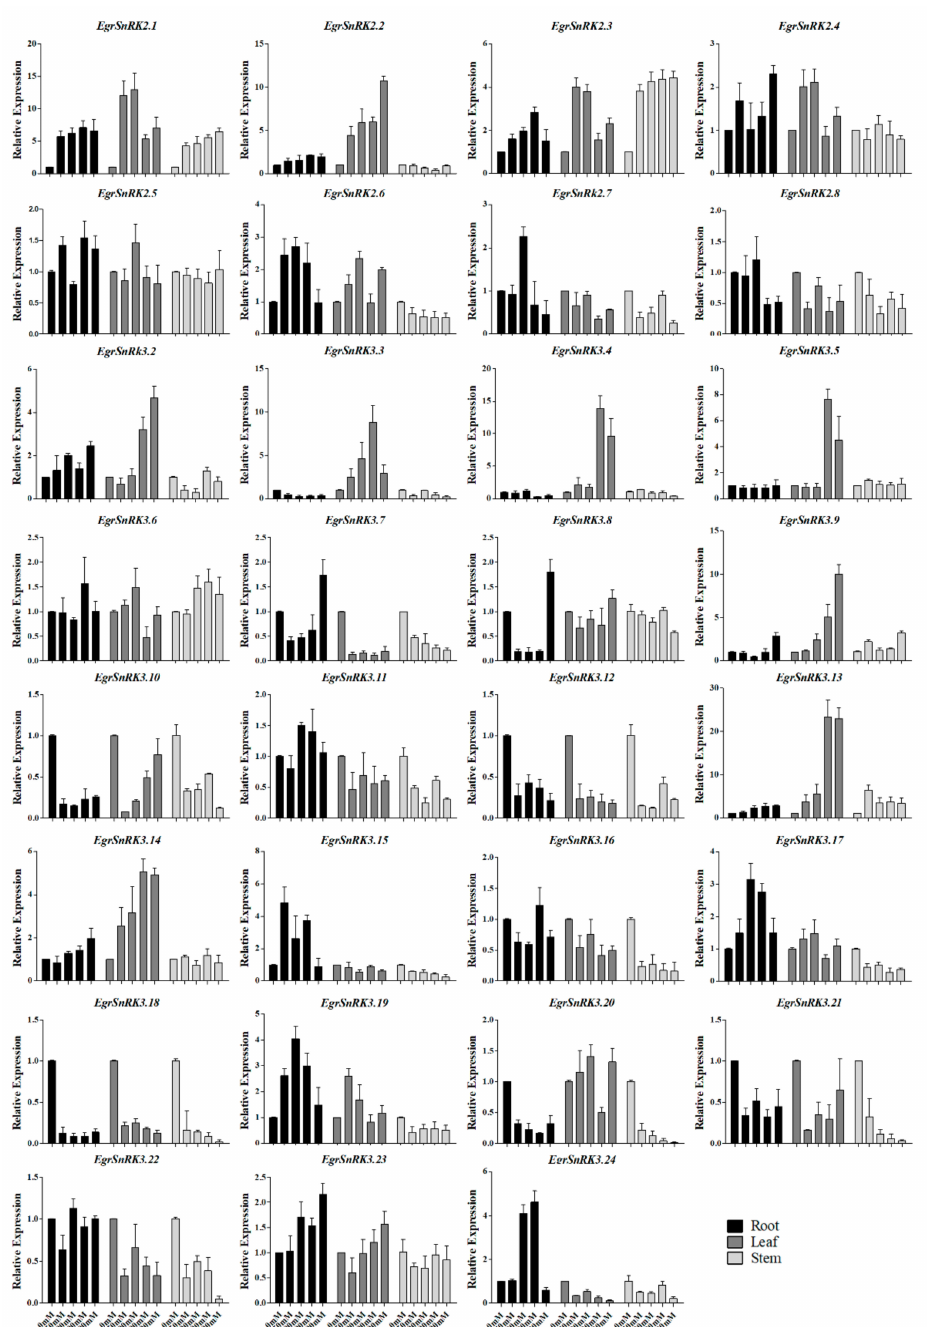
Figure 7. Expression analysis of 31 EgrSnRK genes following NaCl treatment at di ff erent concentrations as determined by qRT-PCR. The Y -axis and X -axis indicates relative expression levels and the time courses of stress treatments, respectively. Mean values and standard deviations (SDs) were obtained from three biological and three technical replicates. The error bars indicate standard